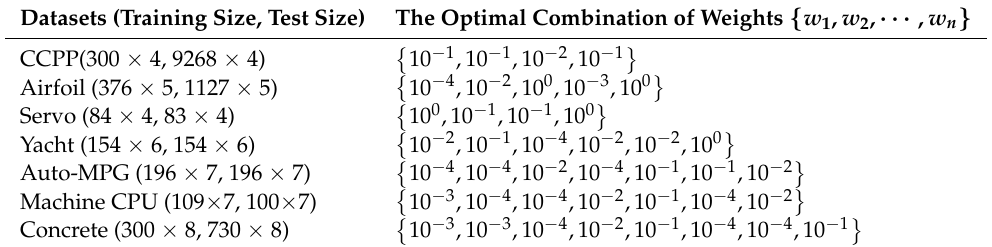
Table 5. The optimal combination of weights for the UCIdatasets.